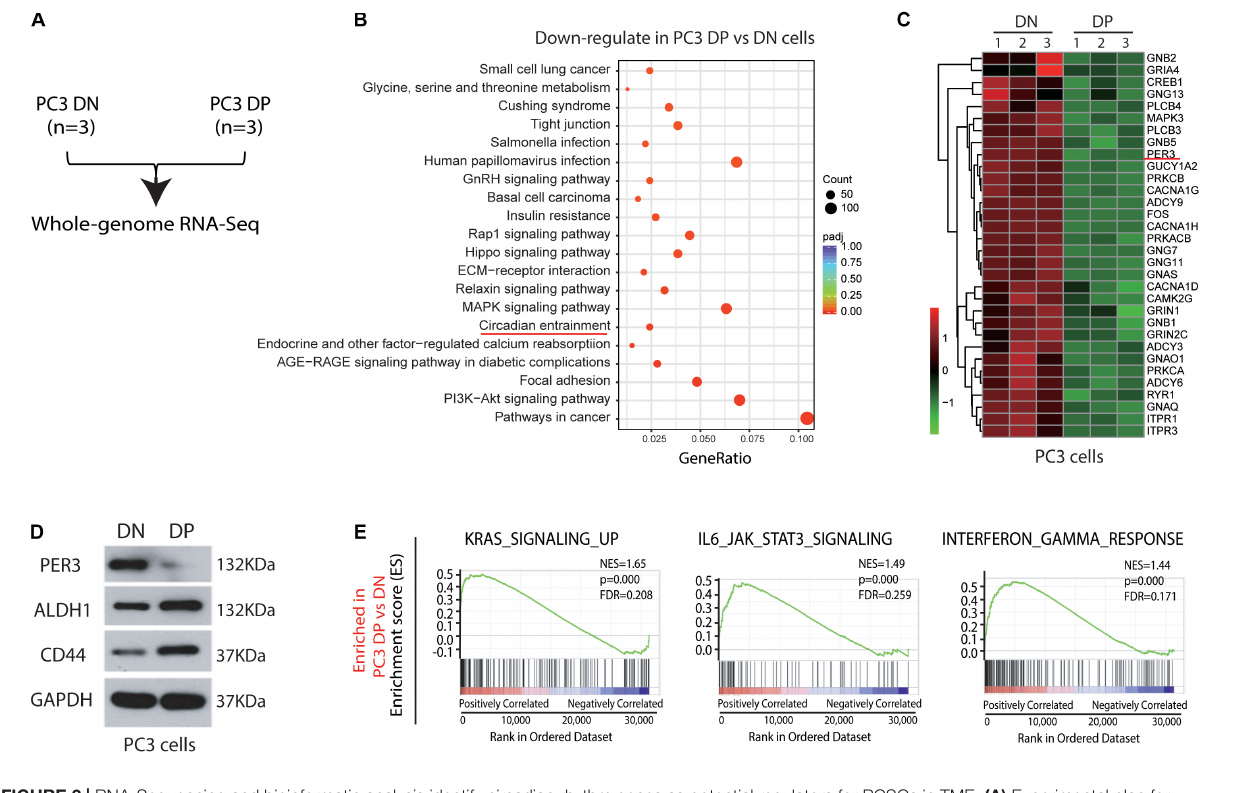
FIGURE 2 | RNA-Sequencing and bioinformatic analysis identify circadian rhythm genes as potential regulators for PCSCs in TME. (A) Experimental plan for RNA-Seq in PC3 cell model. (B) KEGG enrichment of 4,672 DEGs that were downregulated in PC3 DP cells (vs. PC3 DP cells) ( P < 0.05; | log 2 Fold Change| > 0) identified 20 significantly down-regulated pathways. In particular, the circadian entrainment pathway was marked in red. (C) Heatmaps showing representative circadian rhythm genes downregulated in PC3 DP cells compared to DN cells. (D) PER3 level is downregulated in PC3 DP cells at the protein level, whereas CD44 and ALDH1 are upregulated in PC3 DP cells (vs. DN cells). (E) GSEA showing that PC3 DP cells are enriched in gene sets preferentially expressed in stem cell pathways, including KRAS signaling, and IL6/JAK/STAT3 signaling, and also in interferon responses. Data are presented from three independent